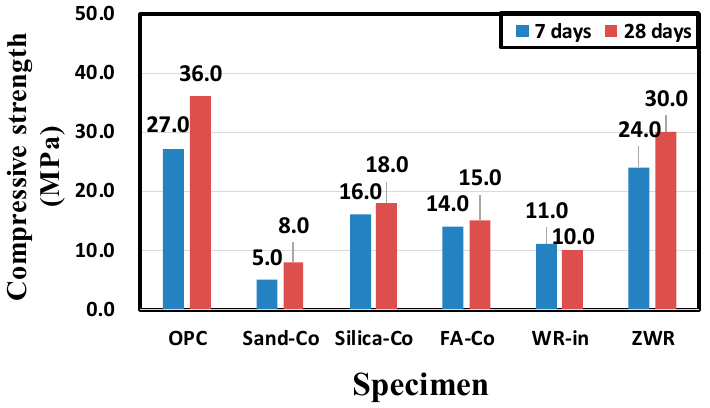
Figure 7. Results of the compressive strength test.